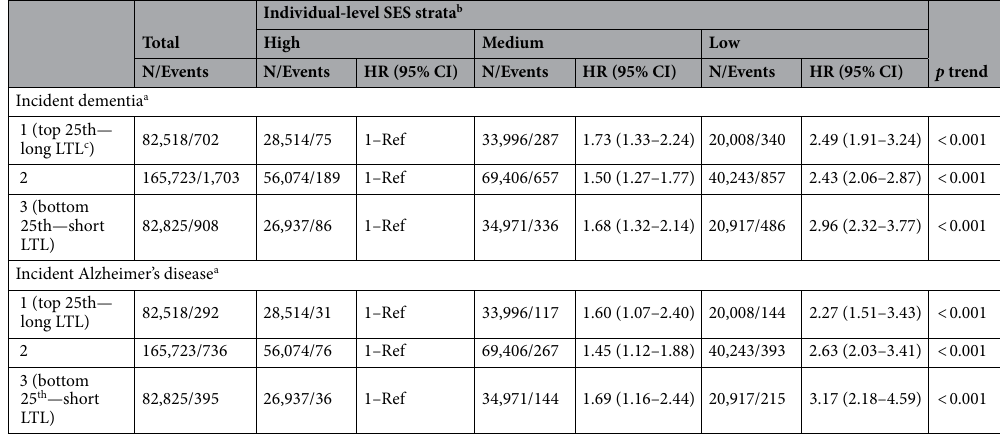
Table 3. Associations between individual-level socioeconomic status (SES) and risks of incident dementia and Alzheimer’s disease stratified by biological age (measured as the adjusted residual of leucocyte telomere length, LTL) among UK Biobank participants. a Model included age, sex, ethnicity, healthy lifestyle score, social activities, hearing difficulty, abdominal obesity, frailty index, urbanicity and neighbourhood deprivation. b Individual-level SES is derived from latent class analysis by using participants’ reported data on highest education attainment, employment status and household income. c Residual of LTL, adjusted for chronological age, C-reactive protein and co-morbidities was defined as biological age in the study. CI Confidence interval; HR Hazard ratio; N Number of participants, LTL Leucocyte telomere